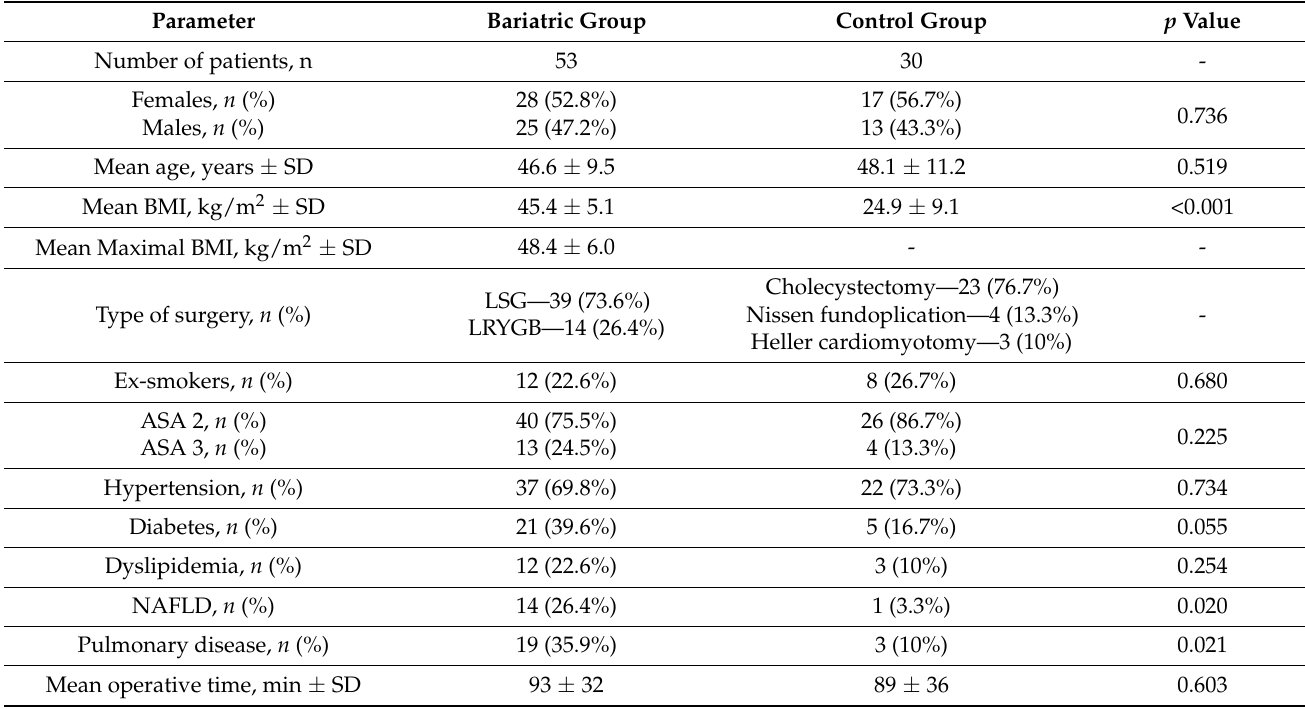
Table 1. Demographic analysis of patient